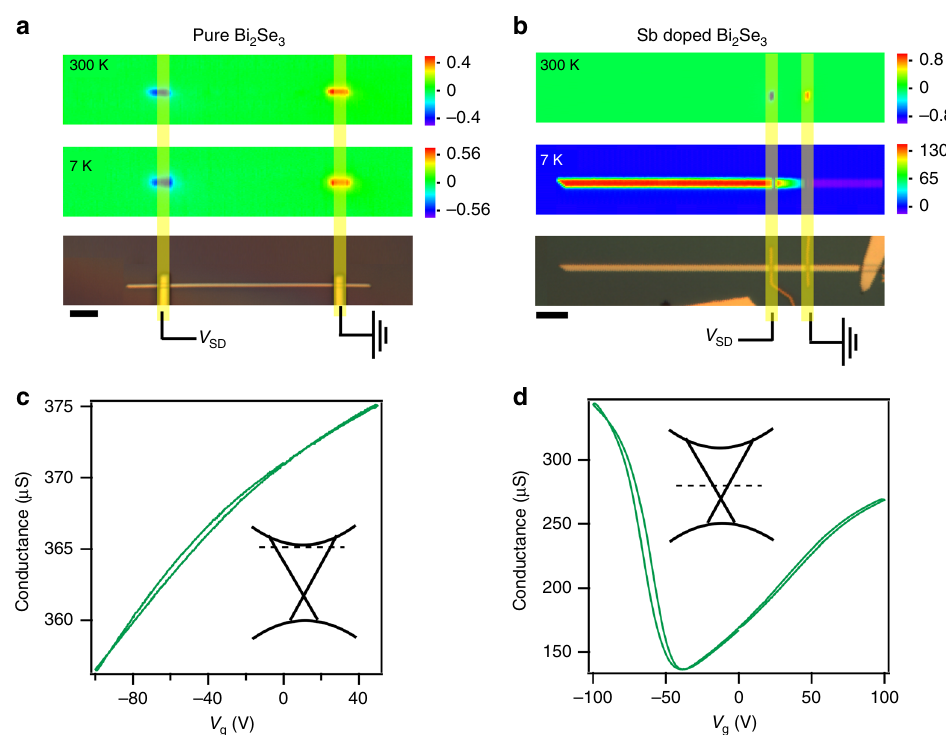
Fig. 3 Doping-dependent photocurrent pro fi les. a, b Photocurrent and optical images, where vertical yellow lines indicate the contacts. Colour scales are current in nanoampere. Laser power is 723 nW. c , d Gate-dependent conductance measured in the dark at 7 K. Insets: band diagrams showing E F positions. a , c are for pure Bi 2 Se 3 , where E F is close to the conduction band. Field-effect mobility and electron concentration are estimated to be μ = 329 cm 2 V − 1 s − 1 , n = 3.25 × 10 18 cm − 3 . The photocurrent is only observed when excitation is close to the contacts. b , d Sb doping lowers E